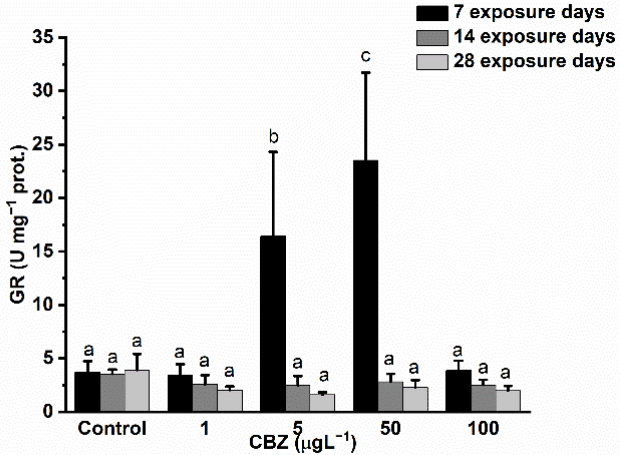
Figure 4. Changes in the GR activity in the liver of Cyprinus carpio subjected to CBZ for 7, 14, and 28 d. Data are expressed as mean ± standard deviation of three replicates ( n = 3). Different letters designate significant differences at p < 0.05 after a two-way ANOVA followed by Tukey’s post-hoc test. SOD activity changes exhibited a very similar response pattern to GR activity. After seven days of 5, 50, and 100 μ g/L CBZ exposure, a significant ( p < 0.05) and concentration ‐ dependent increase was detected. After 100 μ g/L CBZ concentration exposure, activity